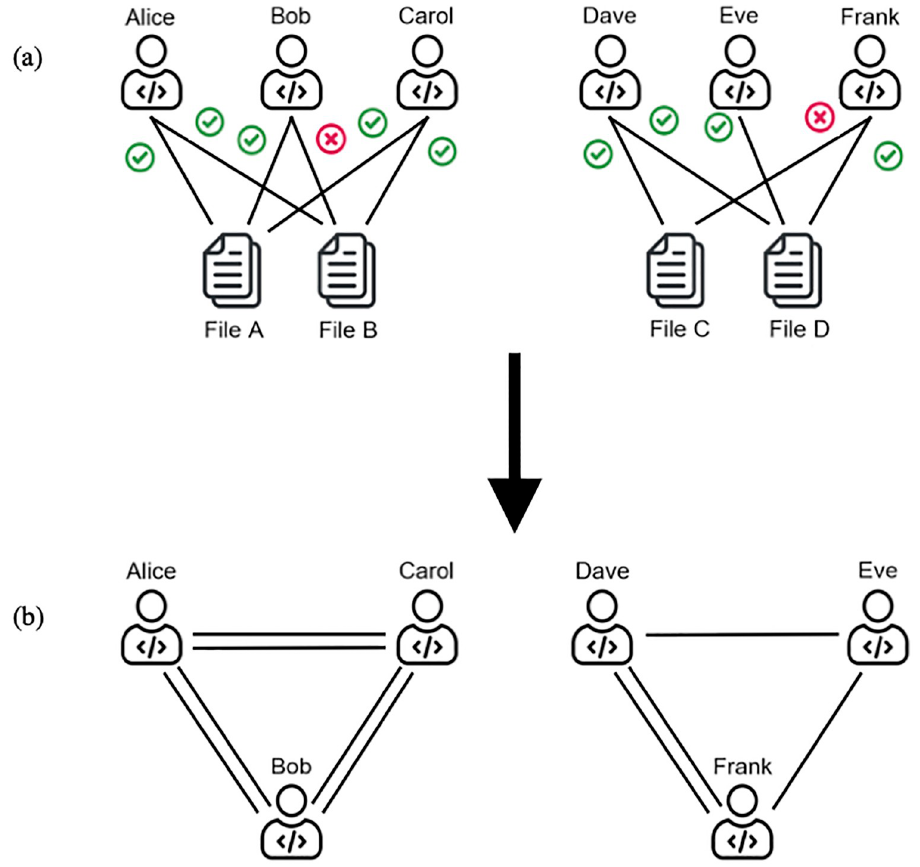
Fig 2. Contribution graph and its projection. a) A toy contribution graph. Check marks represent clean changes, whereas cross marks represent defect-prone changes. (b) Corresponding one-mode projection on the developer side. Classification is driven by developer-based features alone as the one-mode projection graph captures the connectivity around both endpoints (i.e., developer and file) in the contribution